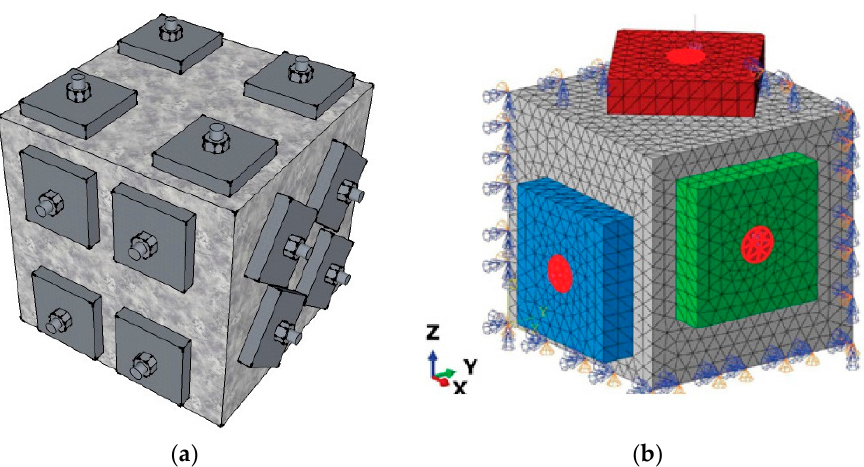
Figure 2. ( a ) Experimental configuration of a concrete cubic specimen with plates and bolts in the three mutually perpendicular directions, adapt from [19]; and ( b ) adopted finite element (FE) mesh of one eighth of the